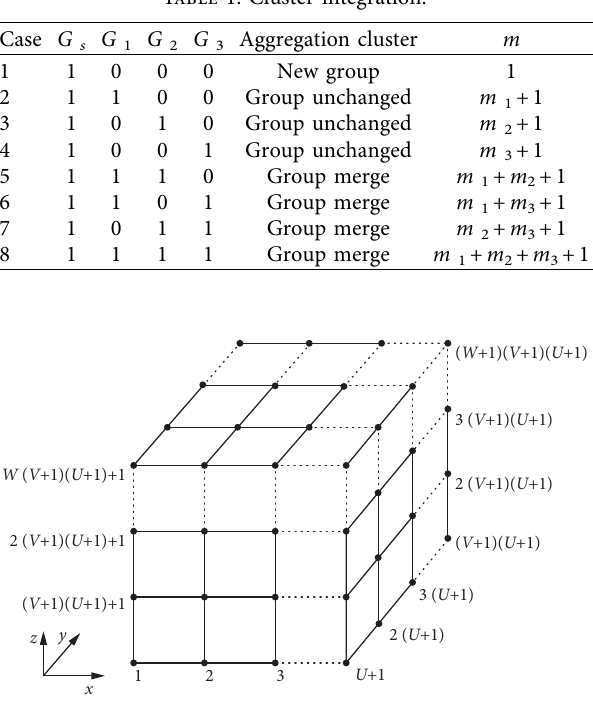
Figure 2: Schematic diagram of adjacent points.